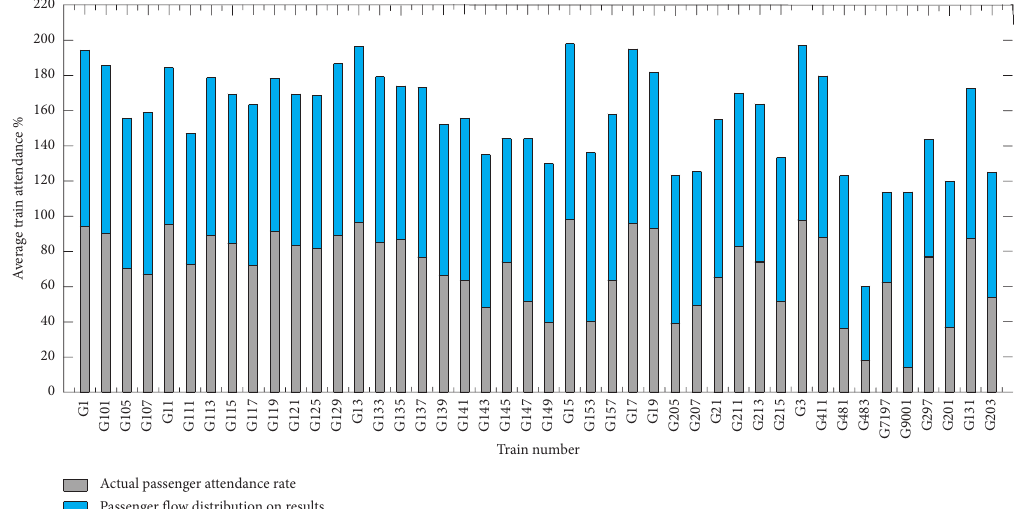
Figure 6: Comparison between actual occupancy rate and calculation